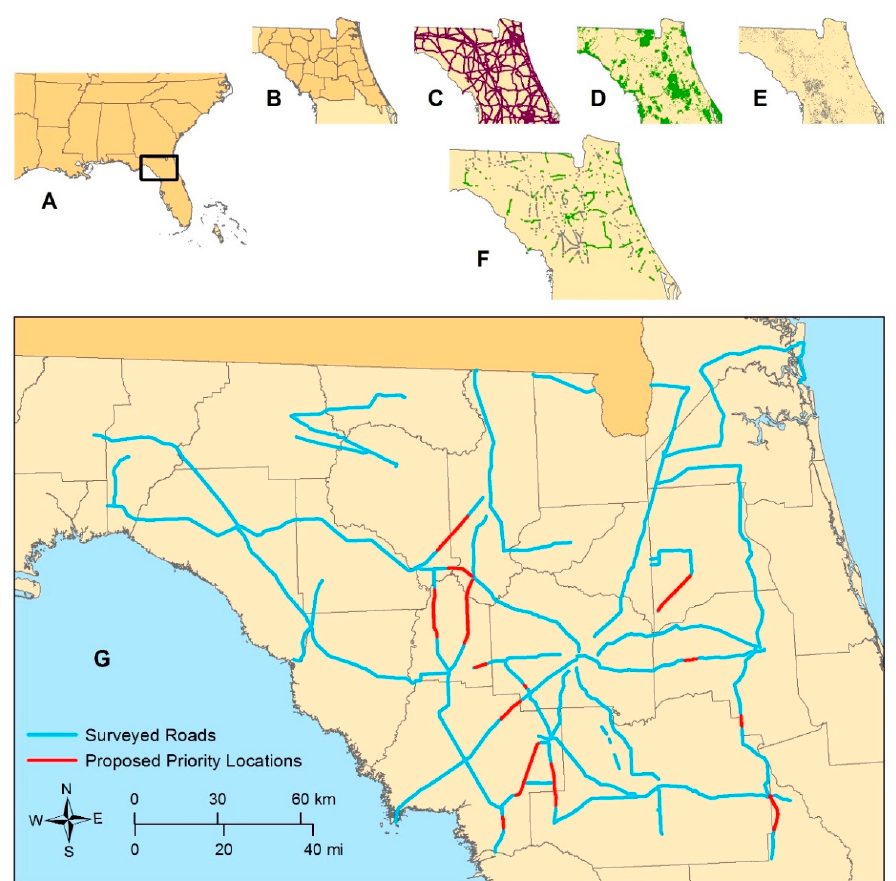
Figure 1. Maps showing project location ( A ), initial survey selection process ( B – E ) and resulting output ( F ), and roads surveyed as well as proposed priority areas ( G ). The selection process to determine higher priorities areas ( F ) was performed by selecting counties in north central Florida ( B ) along state roads ( C ) that were beside conservation lands ( D ) or agricultural areas ( E ). All proposed priority location delineations include a 500 m buffer on either side to more effectively enable Florida Department of Transportation to evaluate a modified mowing scheme.